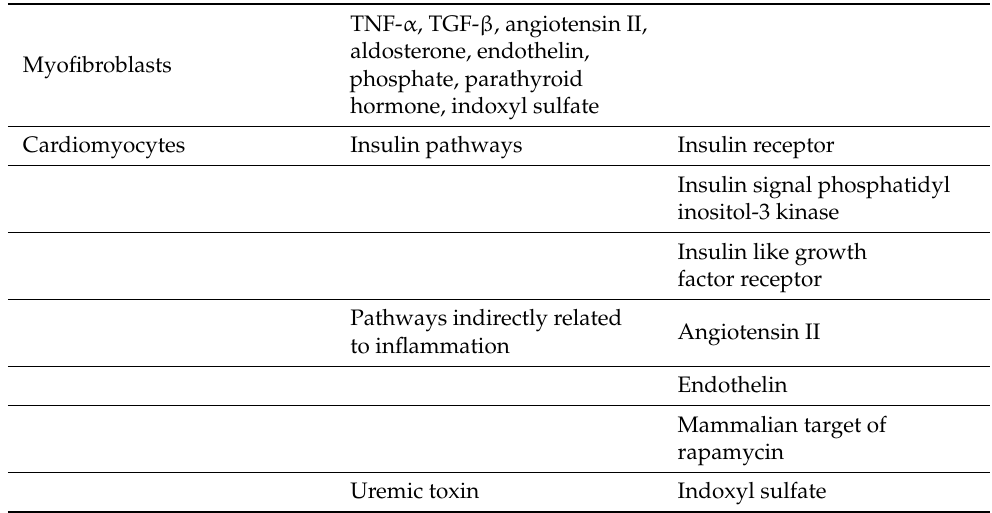
Table 3. Multiple Intermediate Factors in Cardiomyopathy Through Hypertrophy and